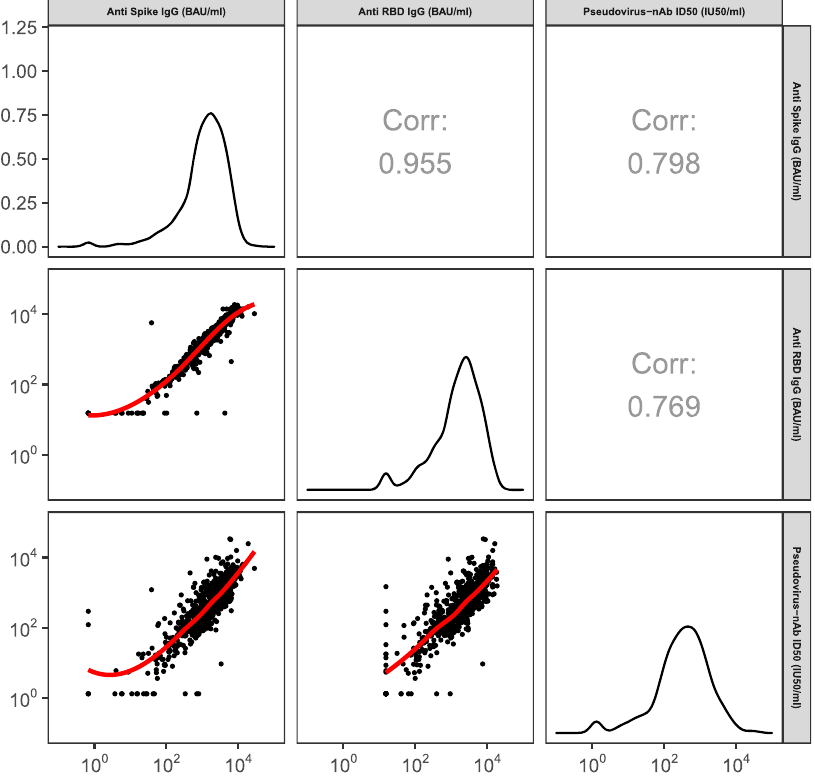
provided in Fig. 2 Source Data fi le. Corr, Spearman rank correlation; D35, Day 35 visit; nAb-ID50, 50% inhibitory dilution neutralizing antibody titer; RBD receptor binding